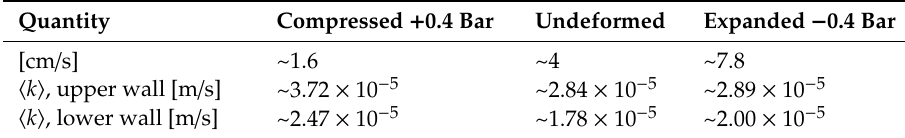
Table 1. Approach velocity and mass transfer coe ffi cients for the load conditions in Figure